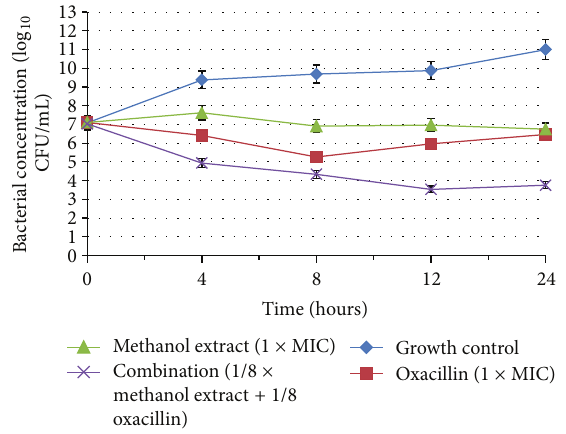
Figure 1: Chart shows the time-kill curve for the growth control, oxacillin, methanol extract, and methanol extract-oxacillin combi-